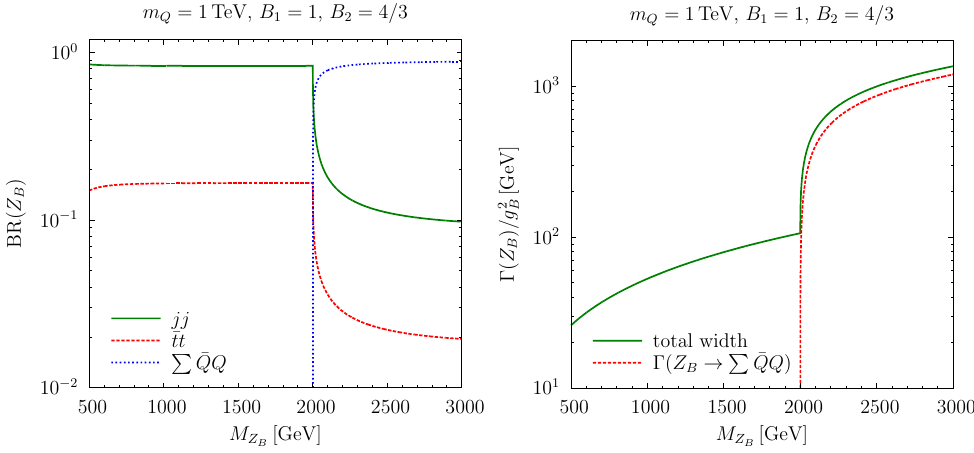
Figure 9 . Branching ratios and total decay width of the leptophobic gauge boson. Here we assume m Q = 1 TeV, B 1 = 1 and B 2 = 4 = 3 for illustration. The decays into all SM quarks except for the top quarks are included in the jj